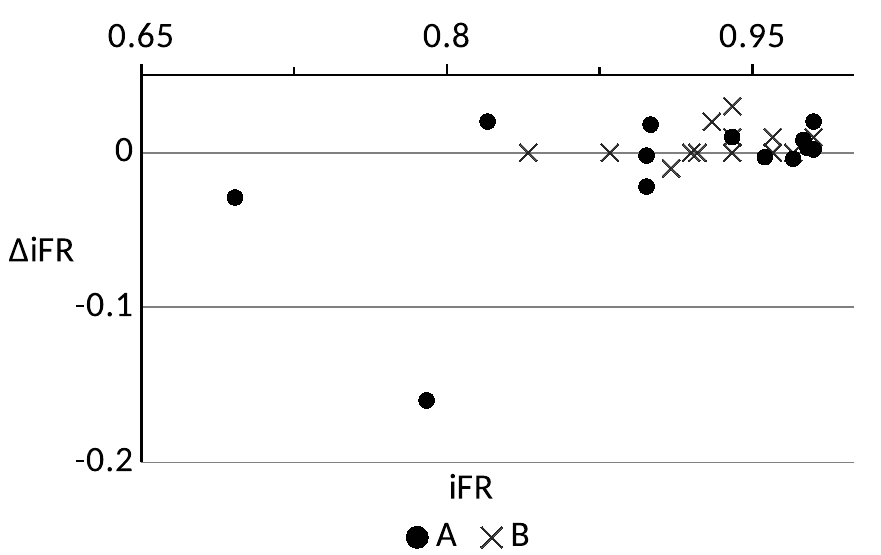
Figure 6. Difference between the iFRs, which were calculated for the full trees and reduced trees (A—terminal points algorithm, B—recursive algorithm).